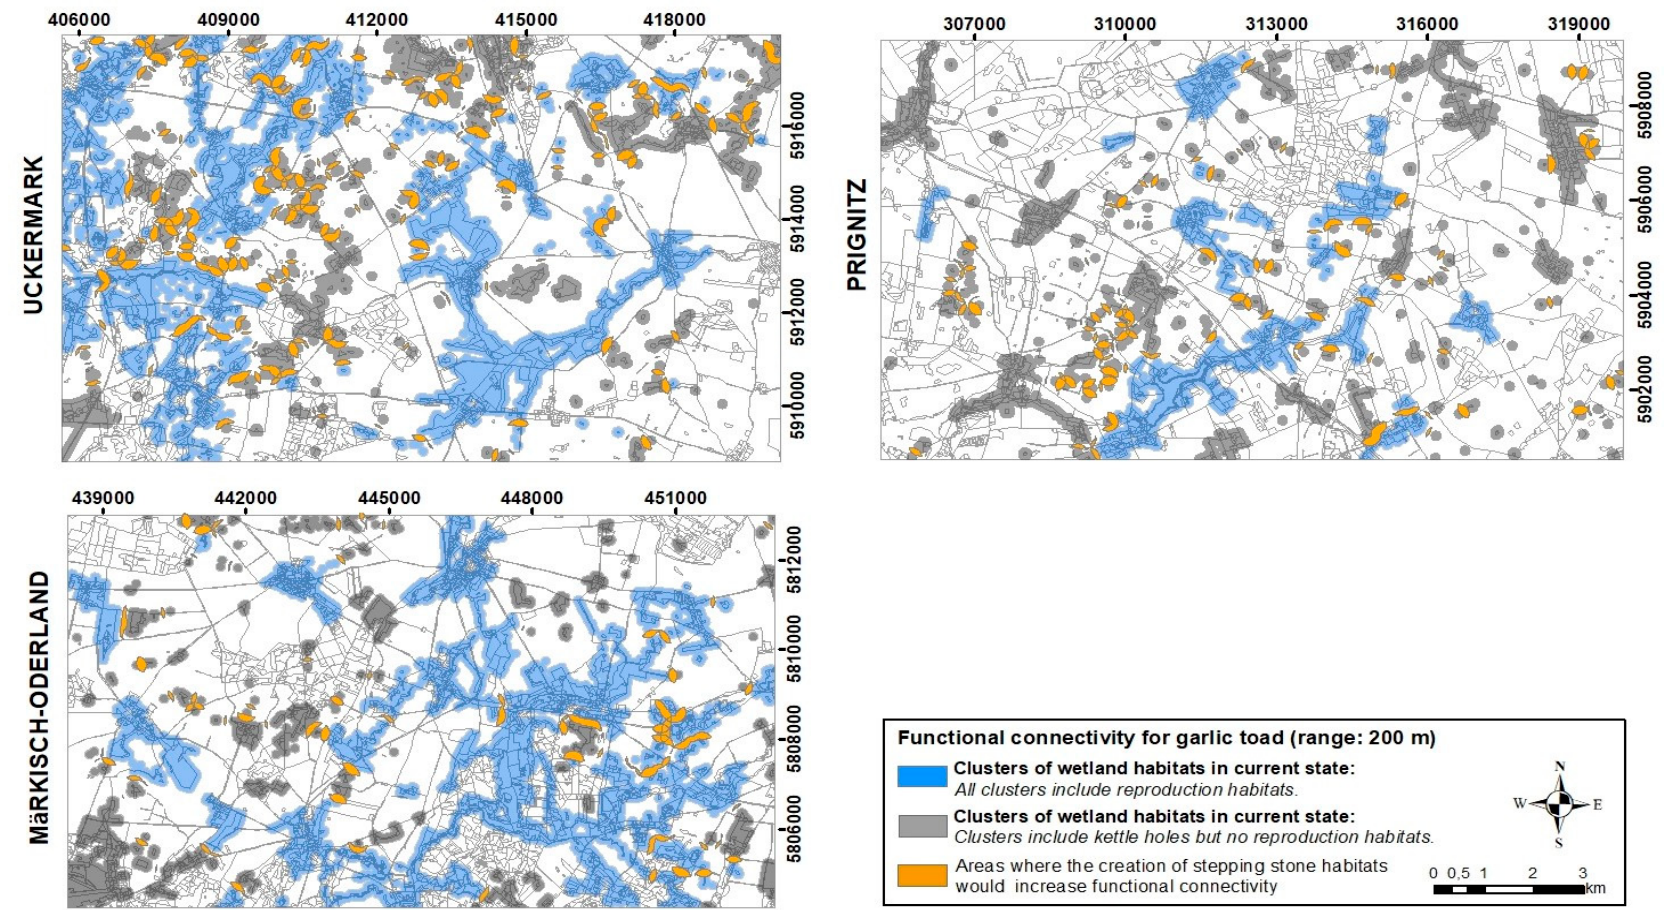
Figure 6. Current state of functional connectivity for garlic toad in (range 200 m) and areas where the creation of stepping stone biotopes would increase functional connectivity (orange).